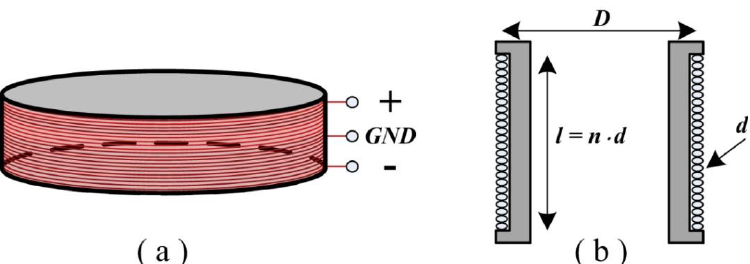
Figure 1. ( a ) Air-core coil with a differential structure; ( b ) typical design of an air-core coil ( l —length of the air-core coil, D —diameter of the air-core coil, d —diameter of wire, and n —number of turns).